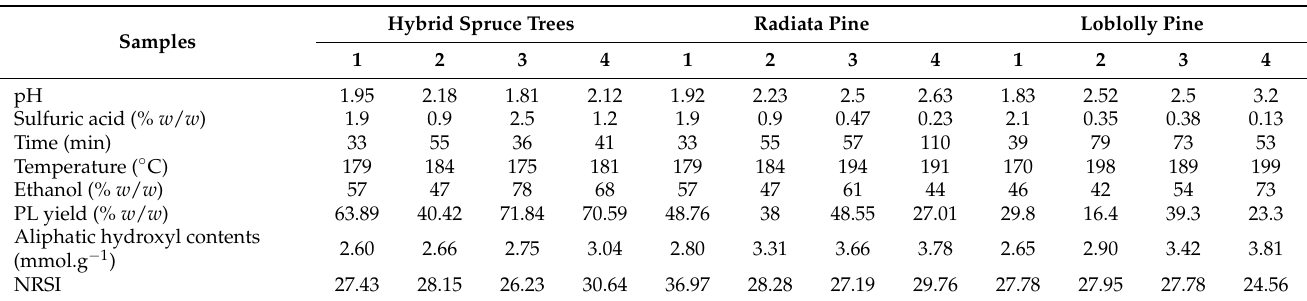
Table 3. Pulping conditions for different wood chip samples at 6:1 liquor-to-wood weight ratio and characterization of the precipitated